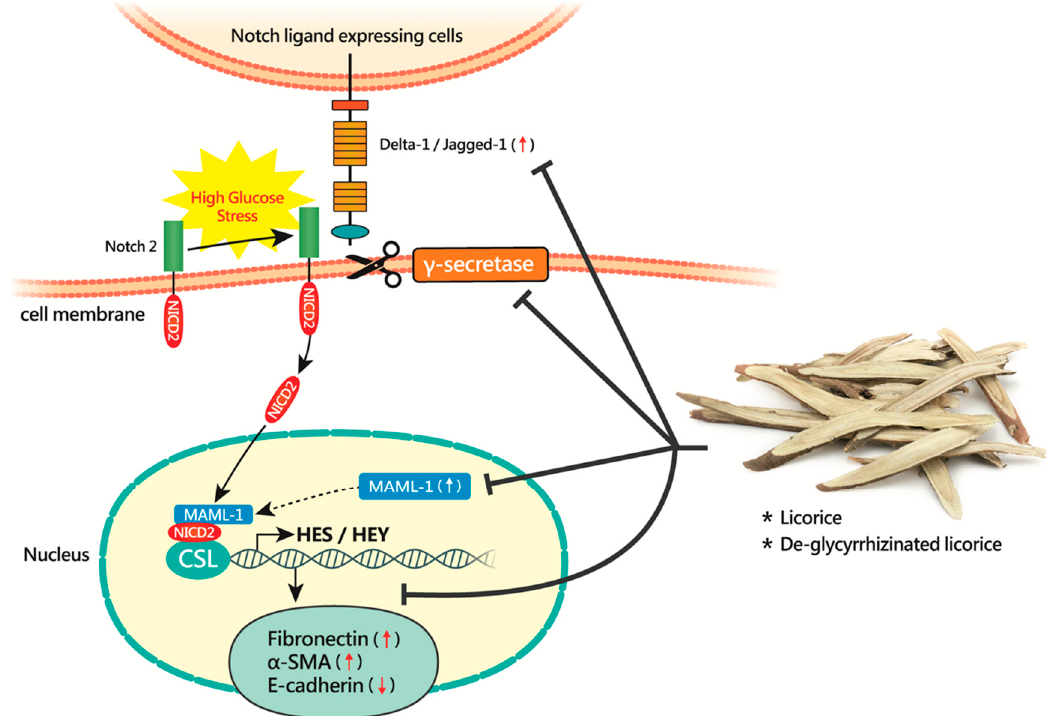
Figure 8. A model for the activation of Notch2 signaling in renal tubular epithelial cells under high glucose conditions and the possible actions of LE or LE / GC-KO in suppressing the Notch2 signaling cascade. Under high glucose conditions, multiple Notch signaling components including Delta-like 1, Jagged-1, cleaved Notch2 (NICD2), nicastrin (a component of the γ -secretase complex), and MAML-1 exhibit marked upregulation in renal tubular epithelial cells. In the nucleus, the activated Notch2 interacting with the transcription factor CSL and the co-activator MAML-1 results in the transcriptional activation of downstream target genes including HES / HEY family members, which are probably required for the modulation of renal tubular EMT and fibrogenesis. As shown in the study, licorice or de-glycyrrhizinated licorice may have di ff erent attenuation mechanisms for the activated Notch2 signaling pathway.